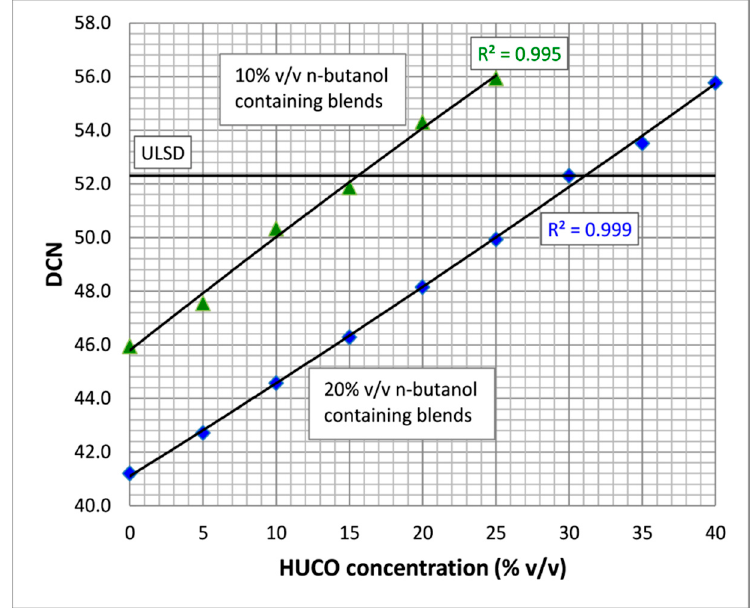
Figure 3. Hydrotreated used cooking oil (HUCO) effect on DCN of 10% and 20% ( v / v ) n -butanol blends.